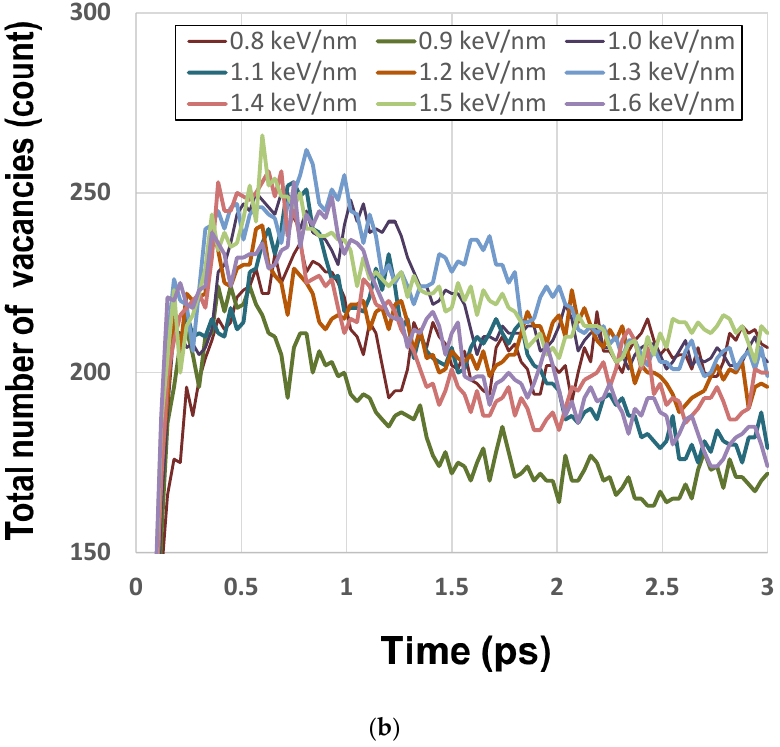
Figure 5. Time change of the total number of vacancies for the values of ( a ) gSe = 0.1–0.8 keV/nm and ( b ) gSe = 0.8–1.6 keV/nm.